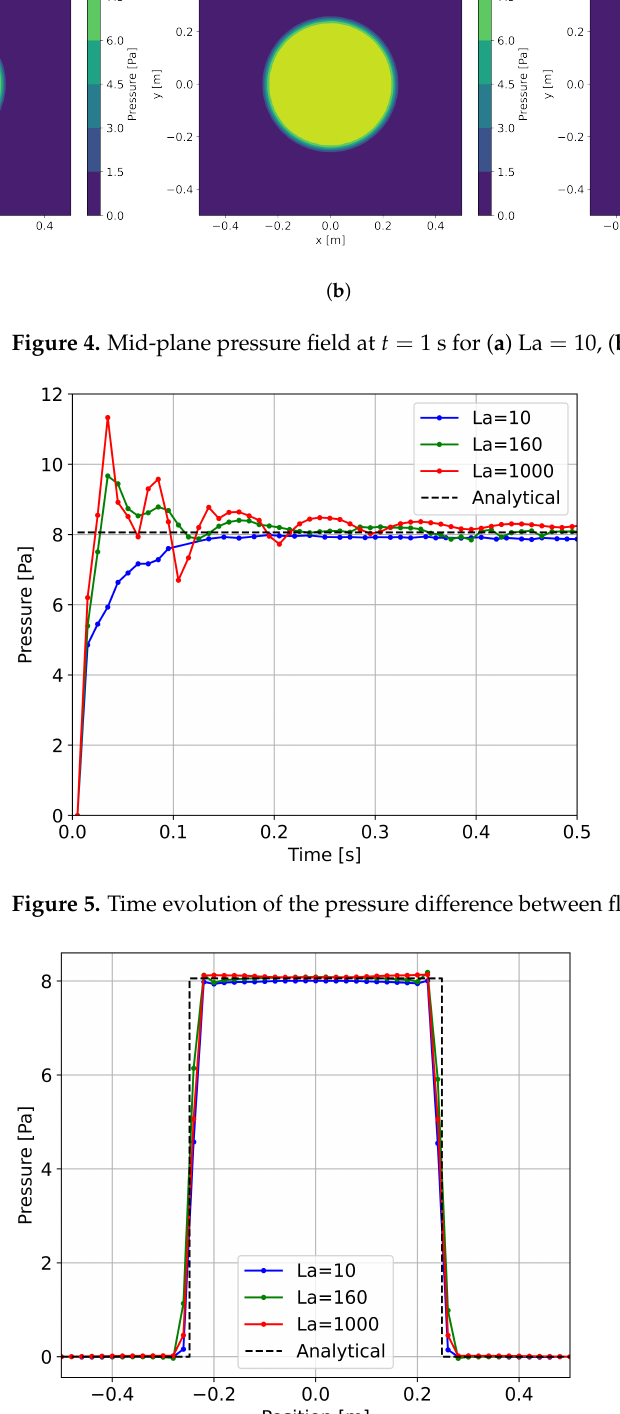
Figure 6. Steady state fluid pressure along the centerline in the x